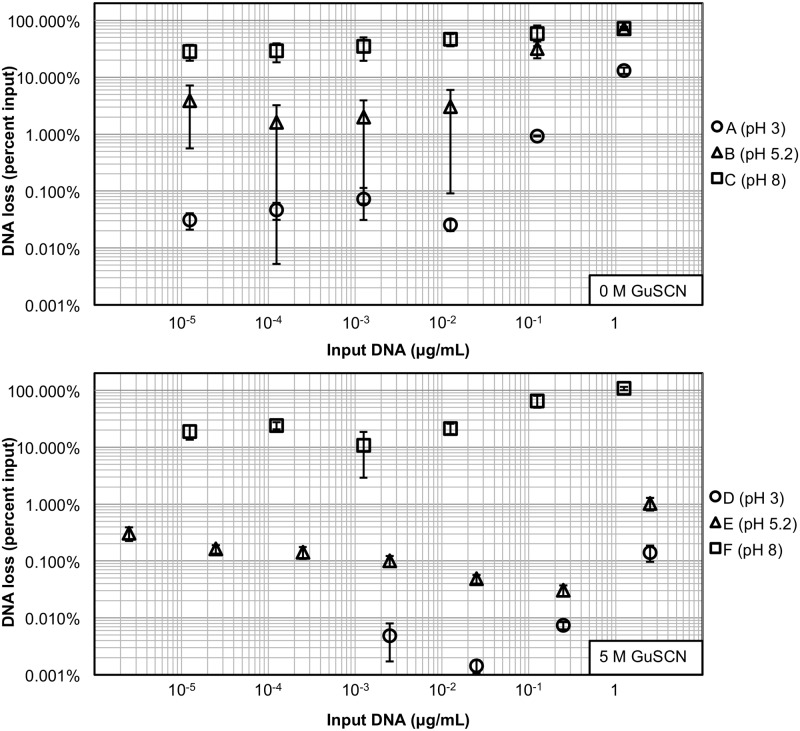
Lost DNA following incubation with silica.Plots show amount of DNA not adsorbed to silica after 1 hour of incubation for each adsorption solution. Solutions tested were pH 3 (circles), 5.2 (triangles), and 8(squares), and solutions D, E, and F also contained 5 M GuSCN. Note that DNA loss for 2.5, 25, and 250 pg/mL are not shown for adsorption solution D, since the signal from those values for unadsorbed DNA fell below that of the no DNA control. (n = 3).